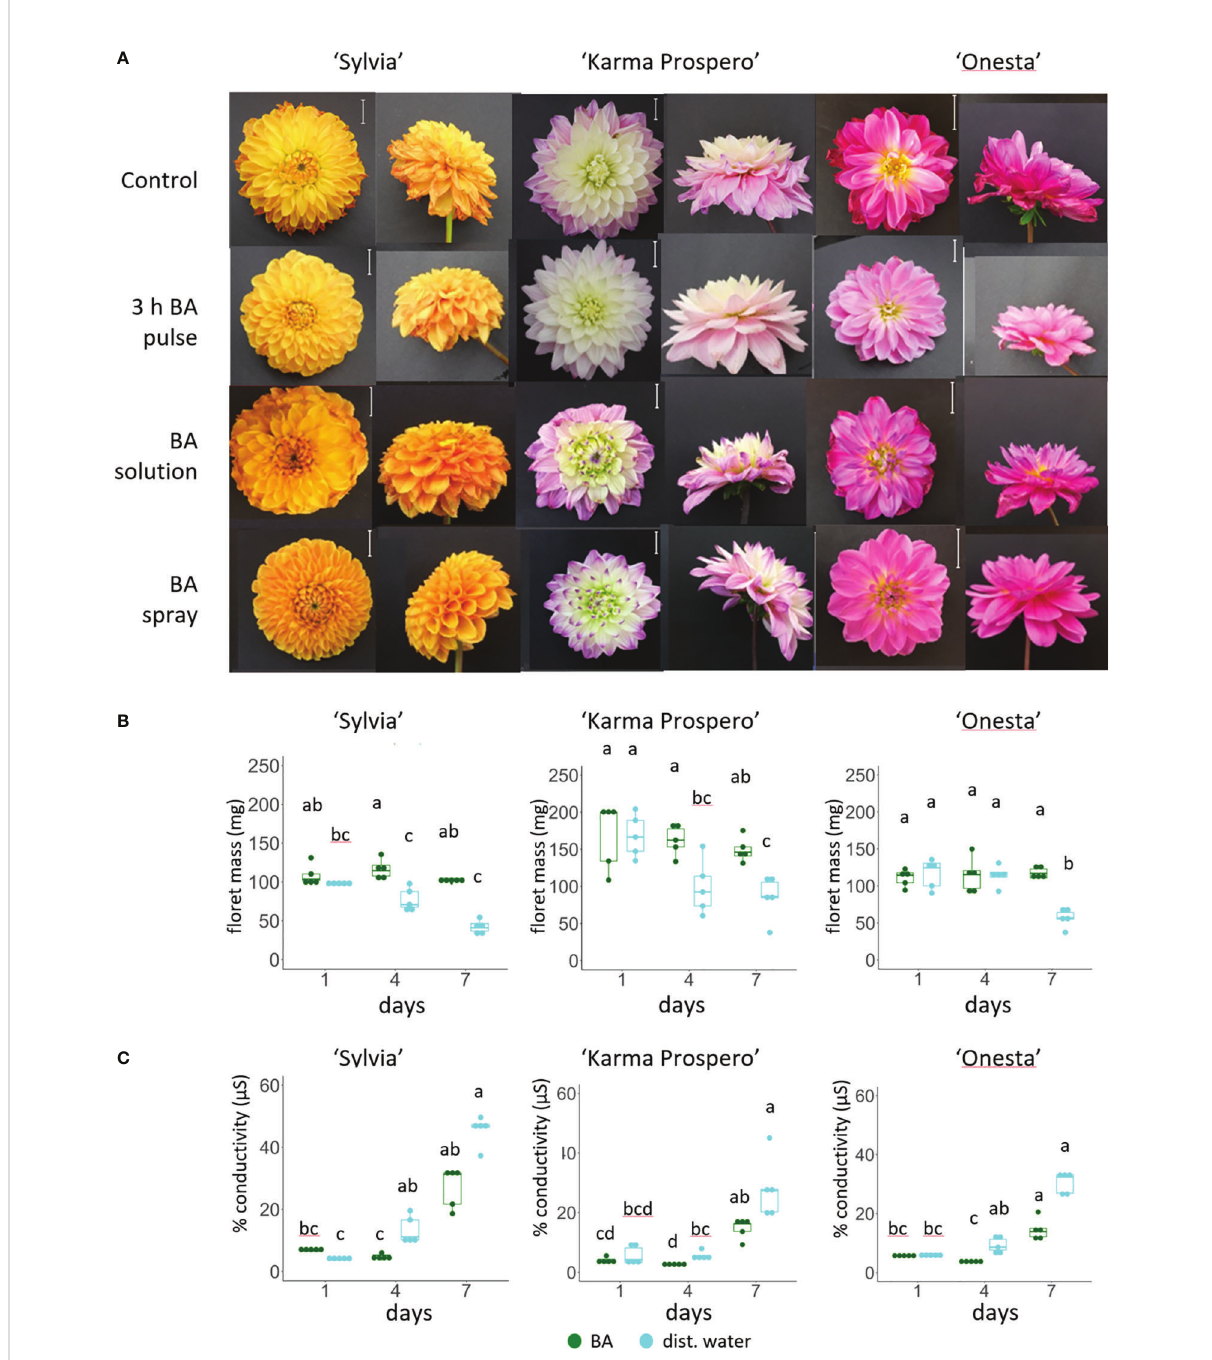
FIGURE 10 Effect of exogenous cytokinin on fl oret senescence in dahlia cv.s Sylvia, Karma Prospero and Onesta. Stems were held in distilled water (control), compared to stems treated with cytokinin (BA) applied as a pulse (100 µM), as a solution (100 µM), or a spray (100 µM). (A) Flower head appearance 7 days after harvesting at Stage III; scale bars represent 20 mm); (B) fl oret mass (C) ion leakage, 1, 4 and 7 days after cutting stage (n=5). Different letters indicate signi fi cant differences p < 0.05, based on a 2-way ANOVA followed by a Tukey ’ s test or a Kruskall Wallis test followed by a Dunn ’ s post hoc test if the data did not fi t the normality and equal variance criteria